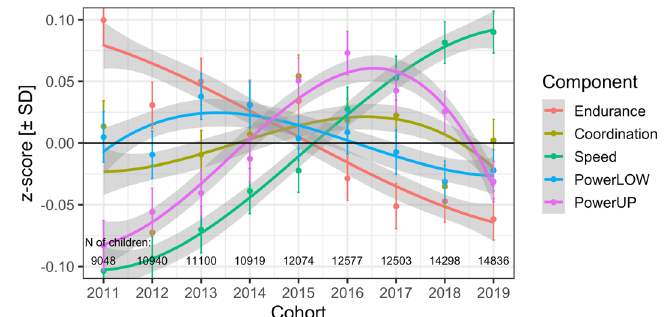
Figure 4. Cohort-related change of components of physical fitness. Points are observed means with 95% CIs. Lines are third-order polynomial trends fitted to children’s scores along with 95% error. Note the much smaller range of the y-axis (i.e., from − 0.10 to + 0.10) compared to age effects shown in Fig. 2. Endurance = cardiorespiratory endurance (i.e., 6 min run test), Coordination = star run test, Speed = 20-m linear sprint test, PowerLOW = power of lower limbs (i.e., standing long jump test), PowerUP = power of upper limbs (i.e., ball push